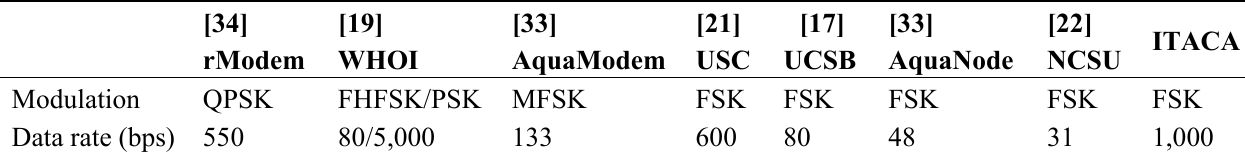
Table 1. Modulation and data rate comparison.